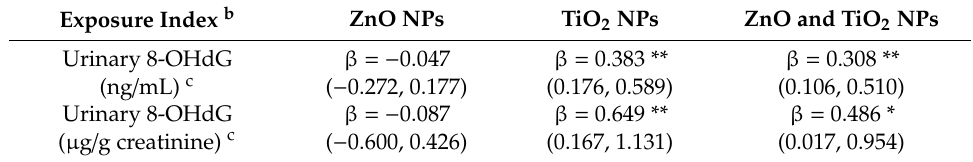
Table 4. Multiple regression analysis of urinary 8-OHdG concentration and exposure index a